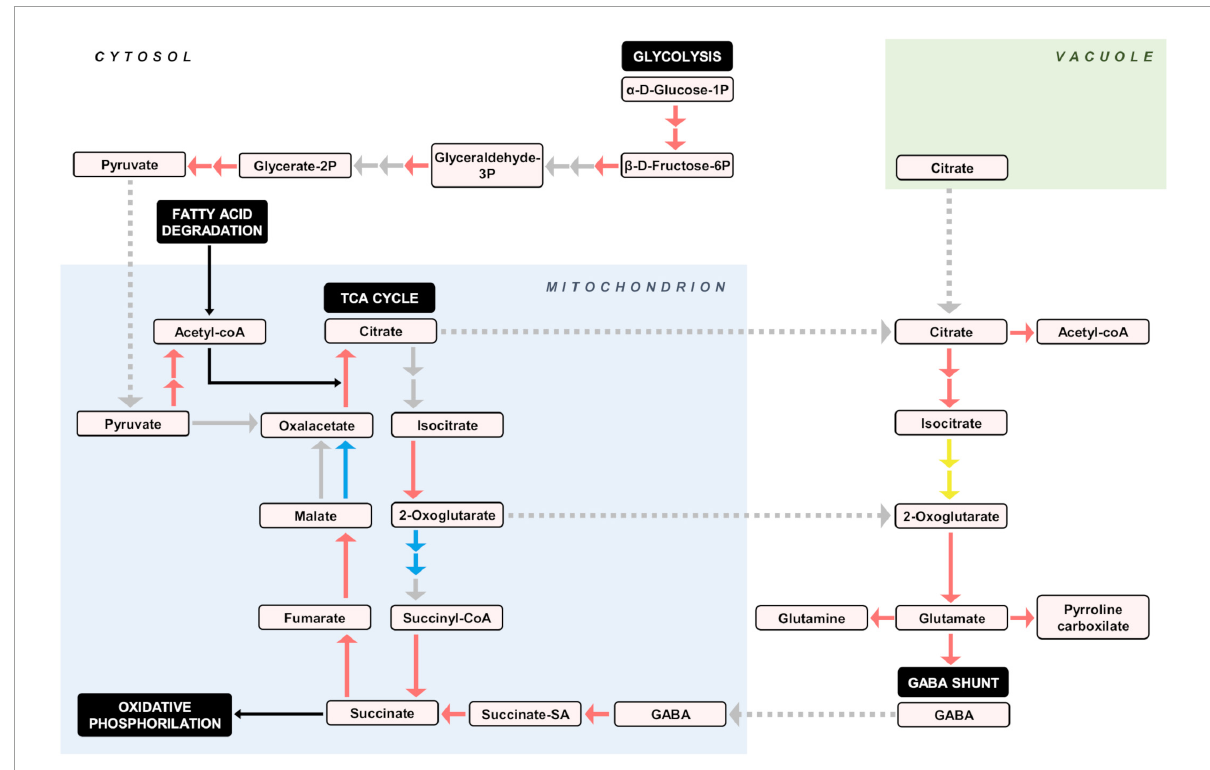
FIGURE6 Proposed activity of central carbon metabolic pathways, deduced from DEGs in the pulp of developing fruitlets of ICH as related to SCM. Bigger solid arrows indicate gene regulation: red = upregulation, blue = downregulation, yellow = undetermined, and gray = no differential expression. Small solid black arrows represent substrate inputs, while gray dotted arrows indicate directional transport. Reaction products and pivotal pathways are embedded in colored and black boxes,